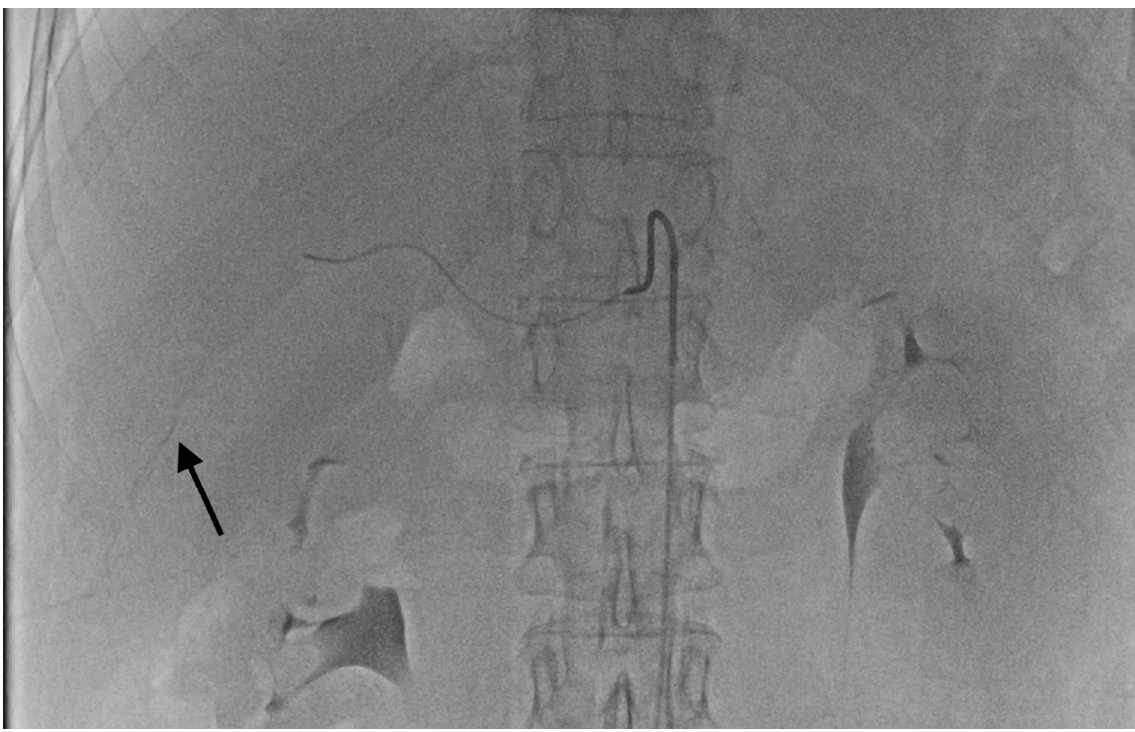
Figure 2. Temporary stasis at the level of the tumor supply vessels (arrow).